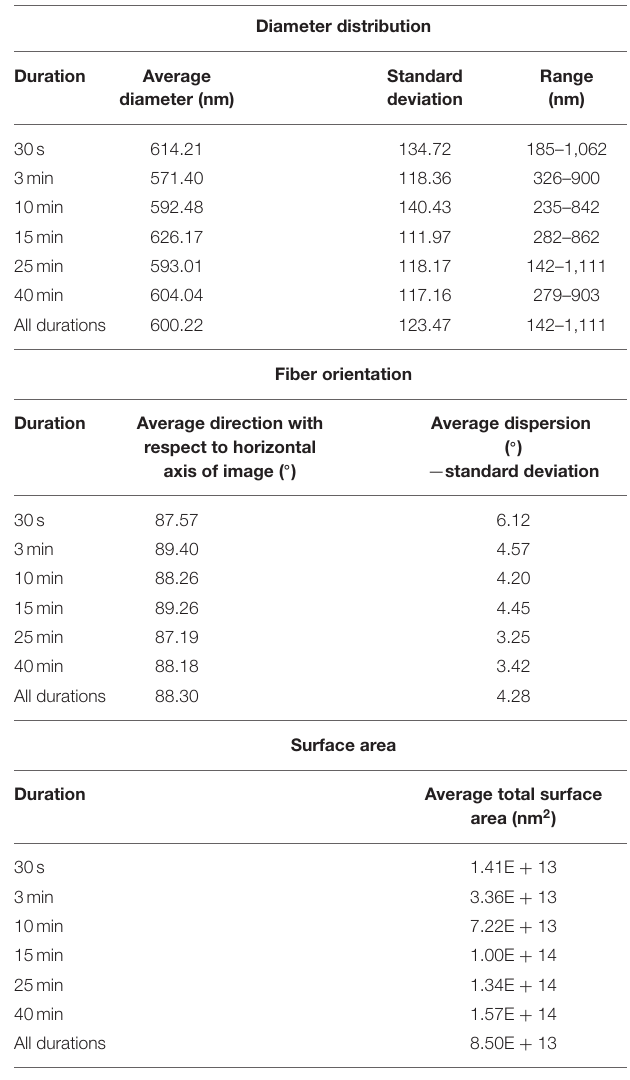
TABLE 1 | Average diameter and range by duration (top), average fiber orientation and standard deviation (middle), and average total surface area (nm 2 ) for each sample